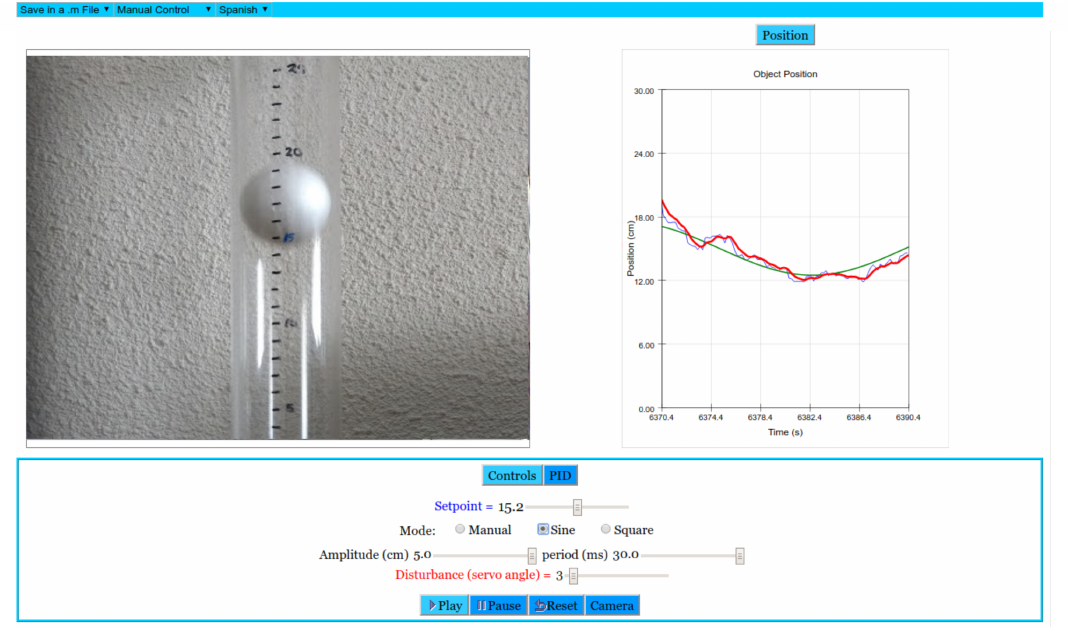
Figure 6. The remote lab of the air levitation